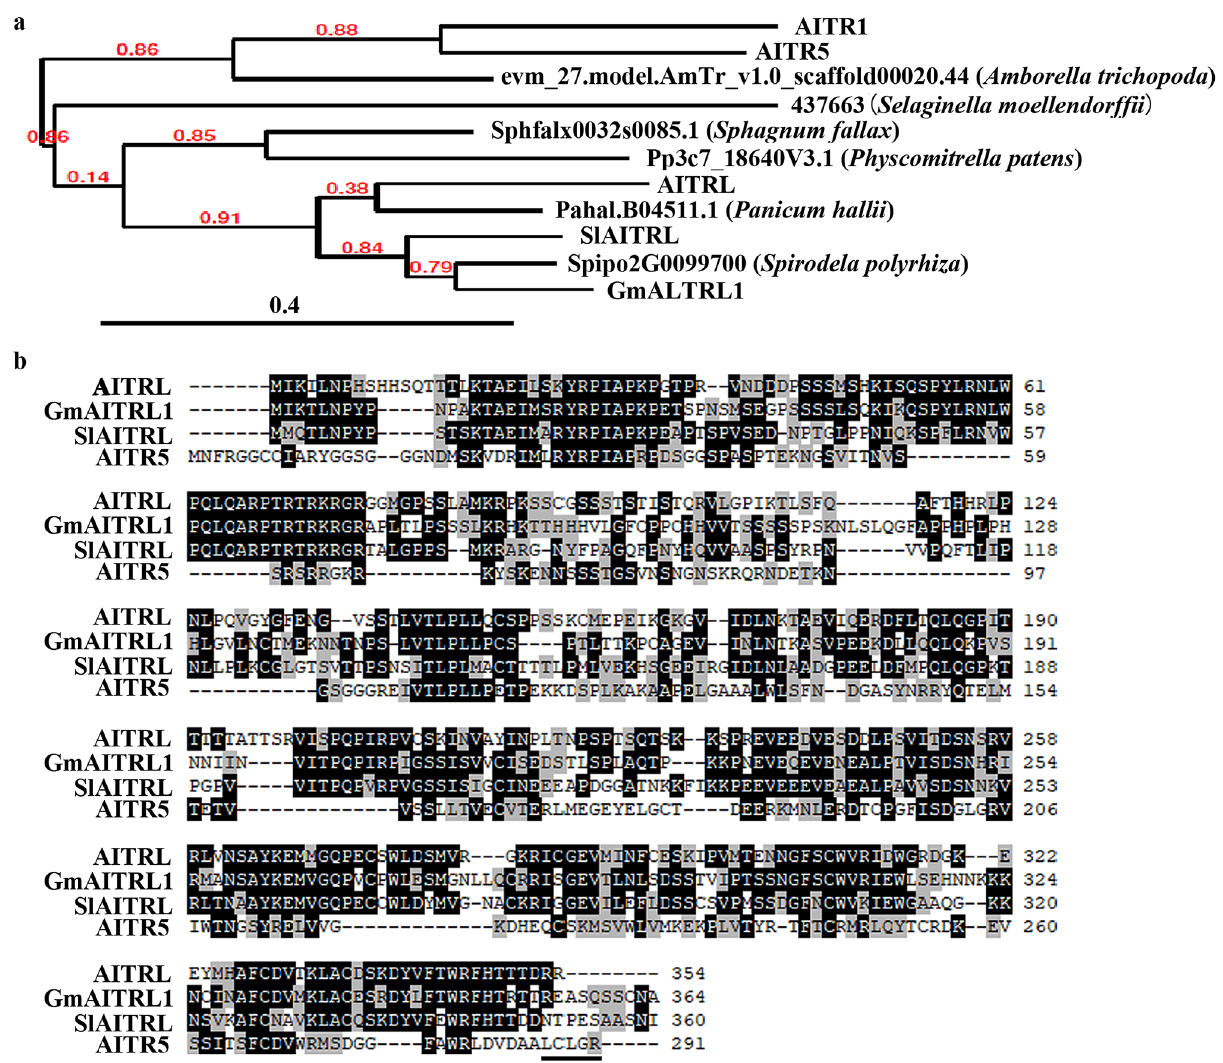
Figure 1. Phylogenetic analysis of AITRs and AITRLs, and amino acid alignment of AITRL, GmAITRL1, SlAITRL and AITR5. ( a ) Phylogenetic analysis of AITRs and AITRLs. AITRs and AITRLs in the plant species selected were identified on phytozome v12 (https ://phyto zome.jgi.doe.gov/pz/porta l.html#), and their full- length amino acid sequences were used for phylogenetic analysis by using “One Click” mode on phylogeny (http://www.phylo geny.fr/simpl e_phylo geny.cgi) with default settings. Branch support values are indicated above the branches. ( b ) Amino acid alignment of AITRL, GmAITRL1, SlAITRL and AITR5. Full-length amino acid sequences of AITRL, GmAITRL1, SlAITRL and AITR5 were obtained on phytozome and used for sequence alignment by using BioEdit 7.0 (https ://bioed it.softw are.infor mer.com/7.0/). The identical amino acids in AITRL, GmAITRL1, SlAITRL and AITR5 were shaded in black, and the similar ones in gray. Underline indicates the partial conserved LxLxL motif in AITRL is a transcription repressor.